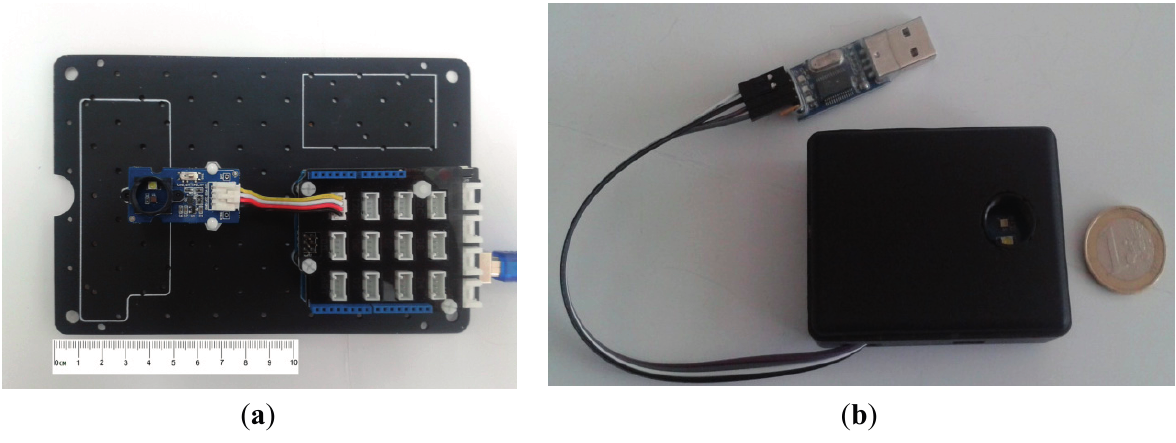
Figure 3. Color picker prototype prototype ( a ) and portable version ( b